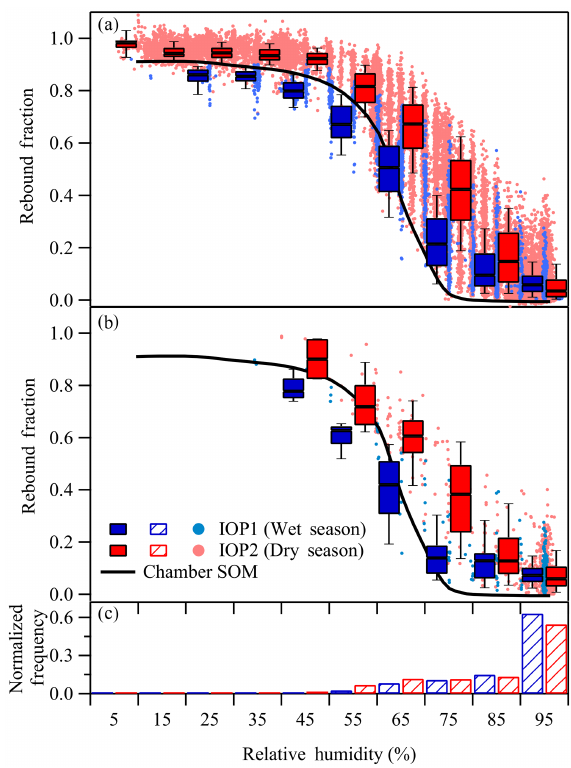
Figure 1. Rebound fraction as a function of apparatus relative hu- midity during IOP1 (blue) and IOP2 (red) corresponding to the wet and dry seasons, respectively, in central Amazonia. Panel (a) shows all measurements. Panel (b) shows the subset of data for which the apparatus RH matched the ambient relative humidity (see Supple- ment Sect. S3). Panel (c) represents the probability density function of relative humidity at the T3 site during the wet and dry seasons of 2014. Points represent rebound measurements for particles having mobility diameters of 190nm. Statistics for measurements groups by relative humidity are represented in box–whisker format. A hor- izontal line within the box indicates the median of the points, the horizontal lines at the box boundaries indicate quartiles, and the horizontal lines most distant from the box indicate 10 and 90% quantiles. For comparison, the black line shows the rebound curve for particles of secondary organic material produced by photooxida- tion of an isoprene/ α –pinene mixture in the Harvard Environmental Chamber (Bateman et al., 2015).